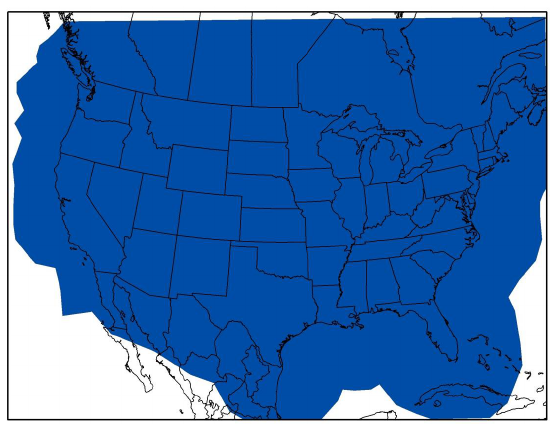
Fig. A1. The geographic extent of NLDN flash data included in this modeling is shown relative to the 36-km modeling domain.